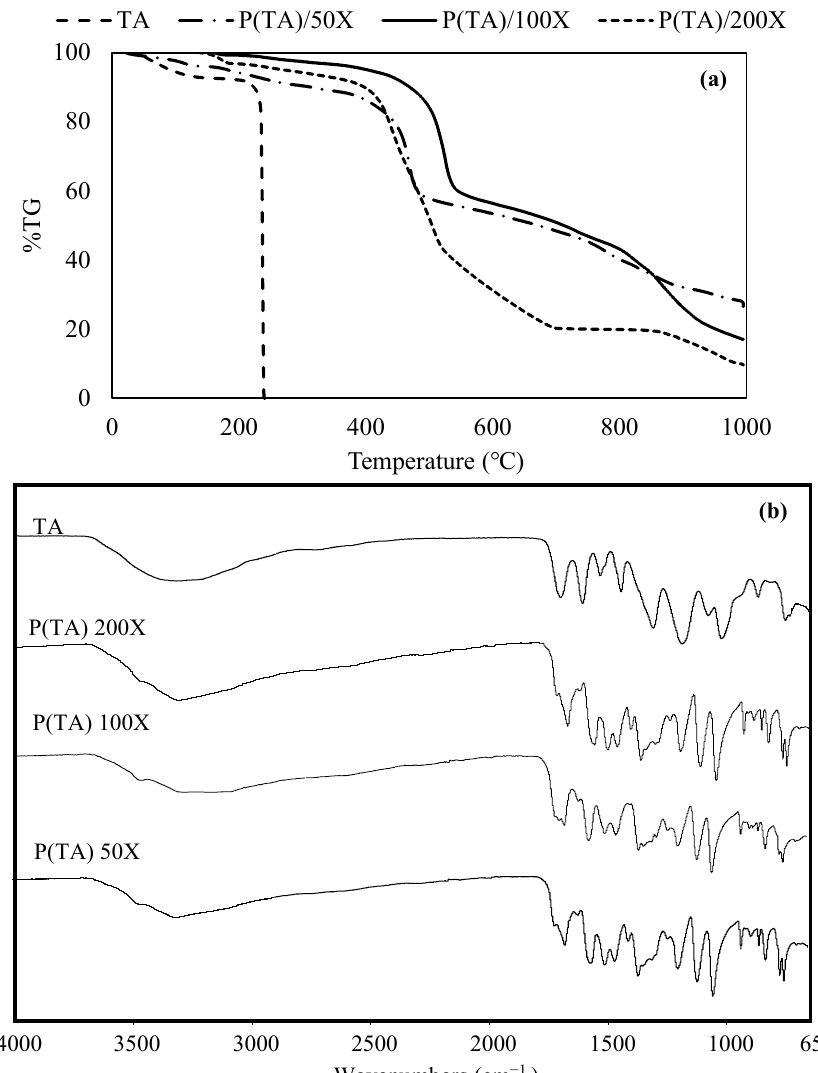
Figure 3. ( a ) Thermal degradation profiles and ( b ) FT-IR spectra of TA molecule and p (TA) particles prepared at different crosslinking ratio.